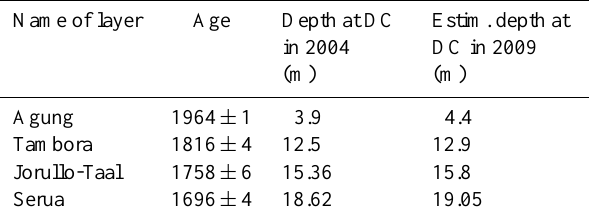
Table 3. Characteristic volcanic layers in the EPICA Dome C core: name, age, depth at DC in 2004 (adapted from Castellano et al., 2005) and estimated depth at DC in 2009 (for an undisturbed sur- face).